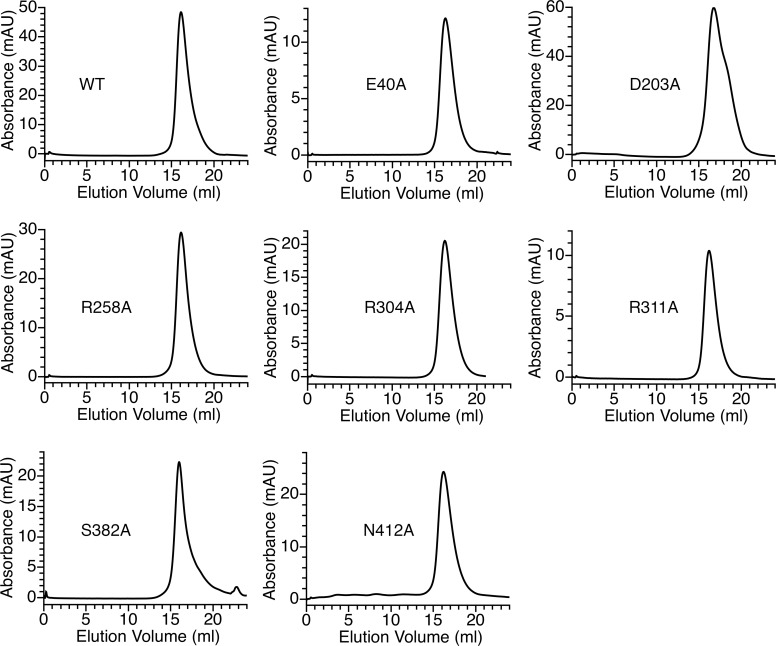
Gel filtration characterization of the wild type and substituted StOAD βγ sub-complex.The experiments were performed on a Supersose 6 column as described in Materials and methods.